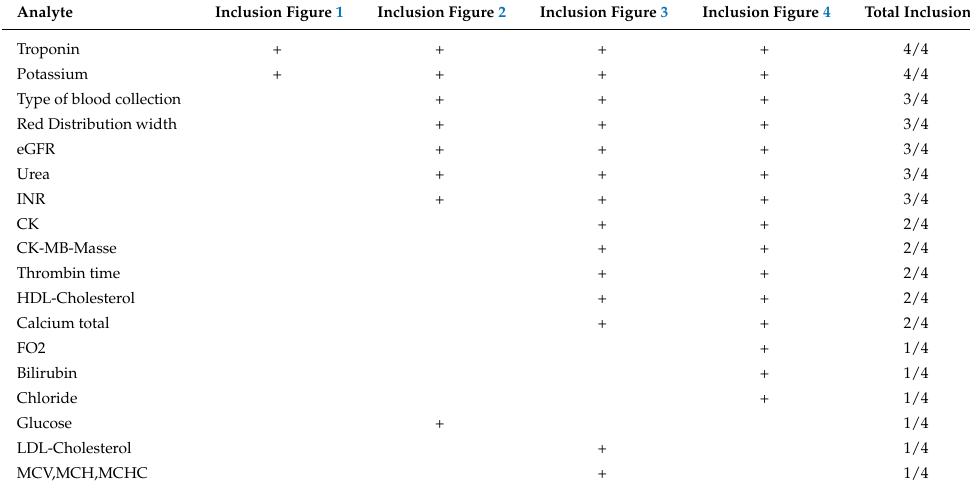
Table 2. Summary of highly predictive analytes. This table summarizes the analytes that show a 95% and above inclusion probability. There are only two analytes that meet these criteria in all four data subsets: TnT and potassium. Most analytes are represented in the data subset with 80% initially missing values, followed by the data subset with 60% initially missing values. Inclusion probablity 95% and above of an analyte in models based on data subsets with initially 20–80% missing values.